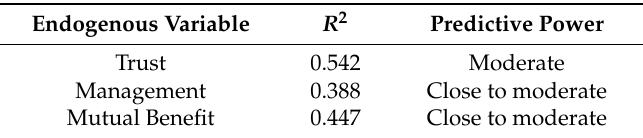
Table 8. Predictive power of the model.